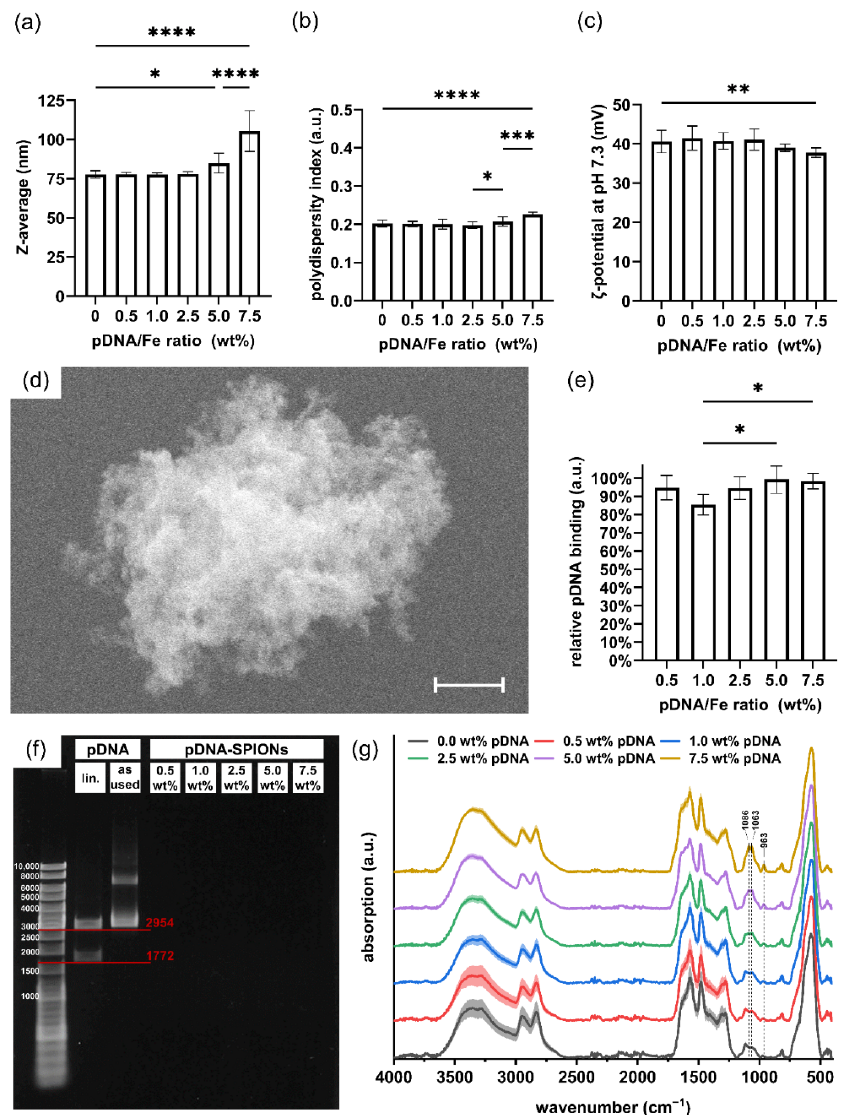
Figure 2. pDNA binding on Caf-PEI-SPIONs and its influence on physicochemical particle parameters. Changes in ( a ) the hydrodynamic size, ( b ) the polydispersity index and ( c ) the ζ -potential at pH 7.3 of pDNA-SPIONs with increasing weight ratio of pDNA/Fe. ( d ) SEM image of an aggregate of 2.5 wt% pDNA-SPIONs consisting of smaller individual particles. The scale bar represents 400 nm. ( e ) Binding efficiencies of various amount of pDNA mixed with Caf-PEI-SPIONs. Statistically significant changes were calculated with ordinary one-way ANOVA (* for p < 0.05, ** for p < 0.01, *** for p < 0.001, **** for p < 0.0001). ( f ) Agarose gel electrophoresis of pDNA-SPIONs showing no free pDNA for all tested pDNA/Fe weight ratios. Bands for digested, linearized (lin.) pDNA are in accordance with the ex- pected sizes of 1772 and 2954 bp. ( g ) FTIR spectra showing the chemical changes on the particle sur- faces by adding higher amounts of pDNA. Spectra are normalized on the peak at ~560 cm − 1 related to Fe-O vibrations. Shades mark the standard deviation of the particle triplicates ( n = 3). The investigated pDNA/Fe ratios exhibited identically high pDNA complexation to the Caf-PEI-SPION system between values from 85% up to 99%, as shown in Figure 2e. Like- wise, an increase in peak intensities which can be related to pDNA (Figure A1c) at wave- numbers 963, 1063 and 1086 cm − 1 can be observed in FTIR analysis (Figure 2g). These peaks